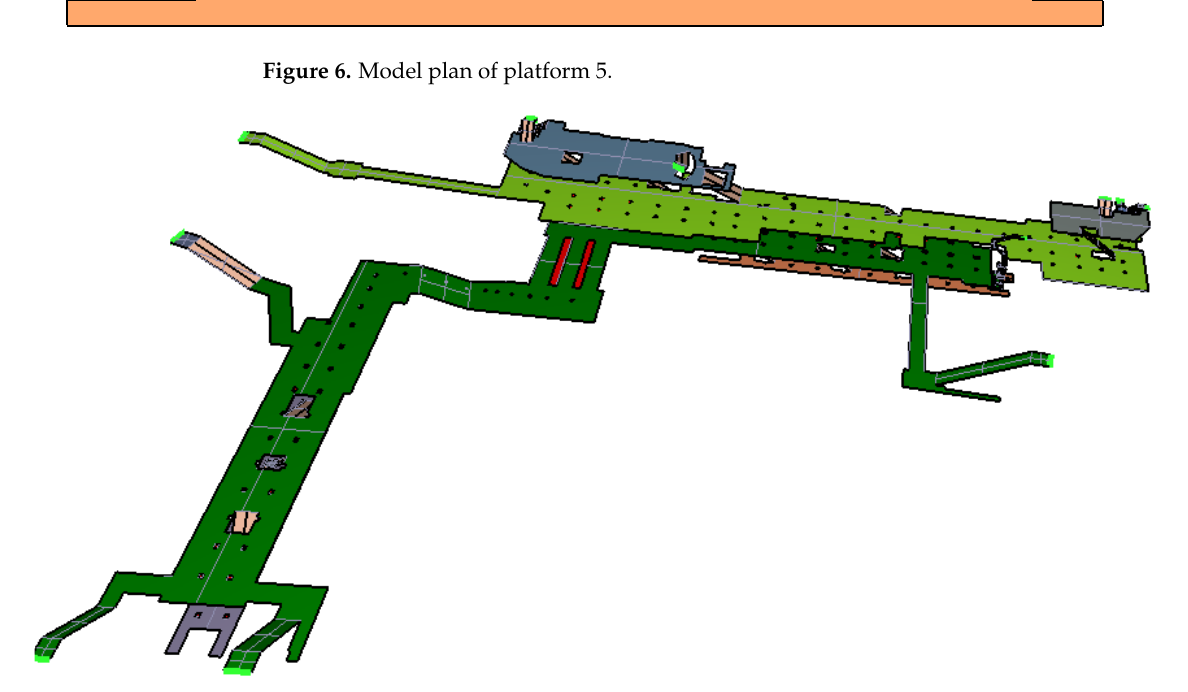
Figure 7. Schematic diagram of the overall 3D model.